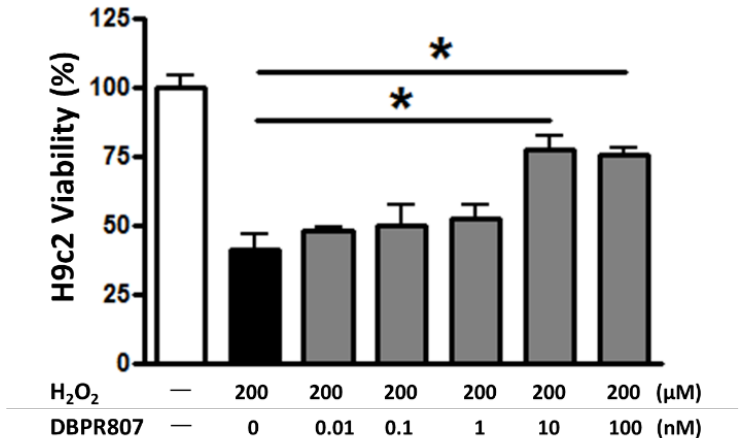
Figure 1. DBPR807 protected against H 2 O 2 -induced injury in H9c2 cells. H9c2 cells were pretreated by indicated concentrations of DBPR807, and then oxidative stress was induced with 200 μM H 2 O 2 . The data are presented as mean ± SEM. Statistical analysis was performed by t -test: * p < 0.05.